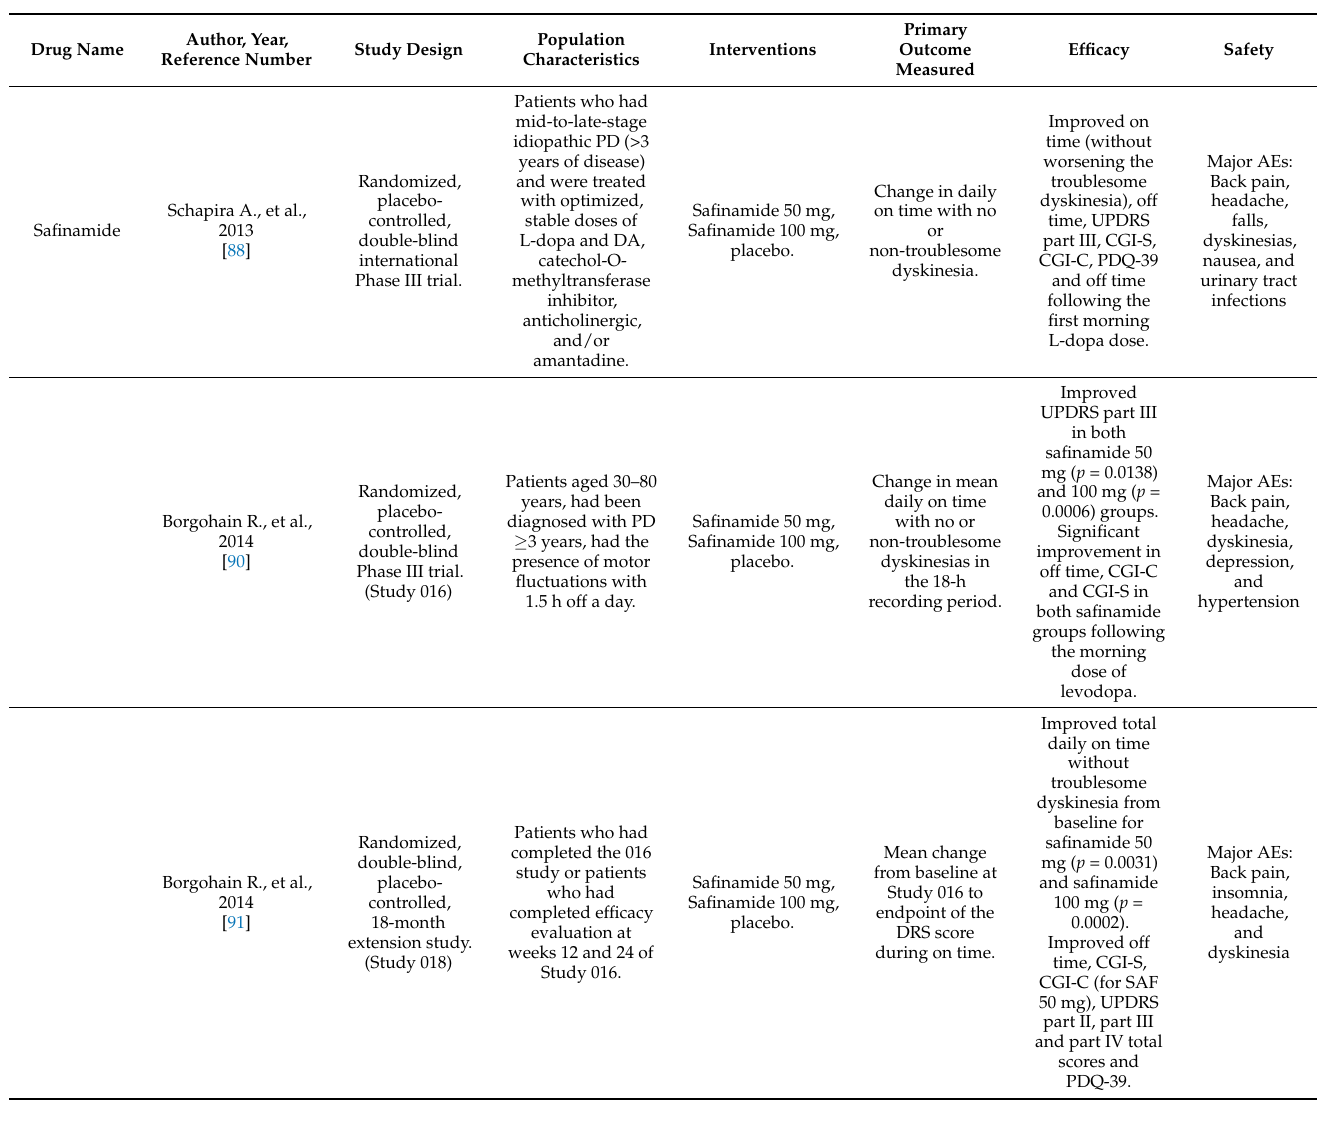
Table 1. Efficacy and safety of the newly approved drugs for treatment of